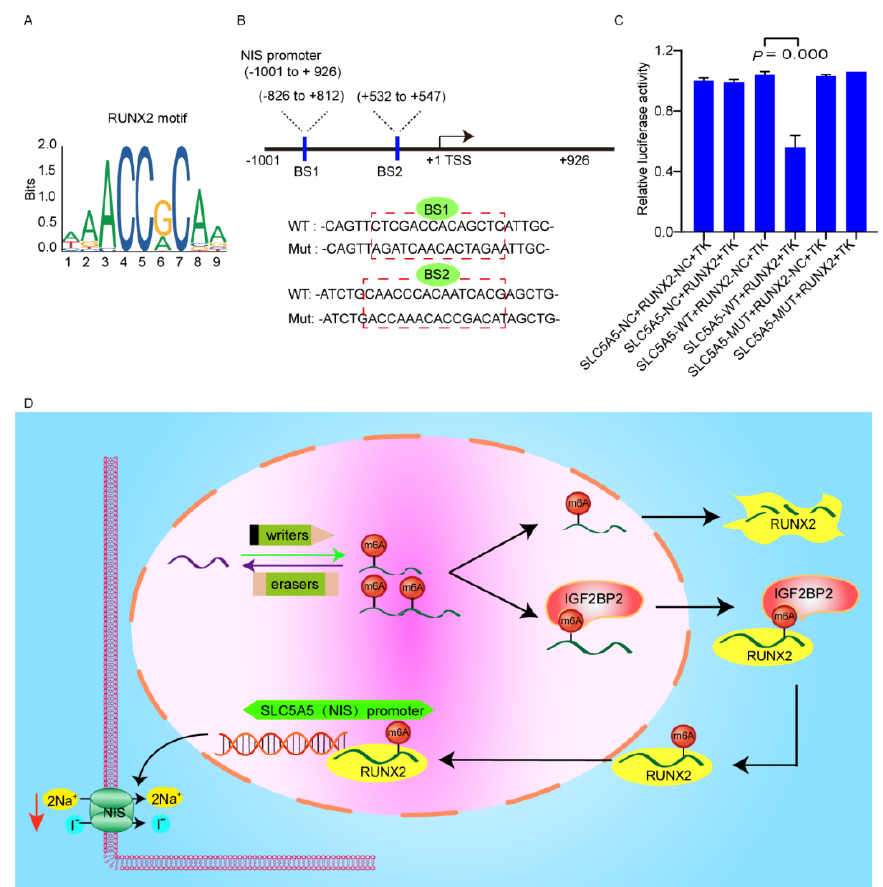
Figure 6. RUNX2 binds to the promoter region of NIS. ( A ) The consensus motif of RUNX2 is illustrated based on the JASPER database. ( B ) Graphical explanation for construction of luciferase reporters with wild-type or mutant sequence of promoter region of NIS inserting into a pGL3 vector. ( C ) Relative luciferase activities in TPC1 cells with stably expressing RUNX2 or vector co-transfected with the NIS-luciferase reporters. ( D ) Working model of IGF2BP2/RUNX2-mediated dedifferentiation of